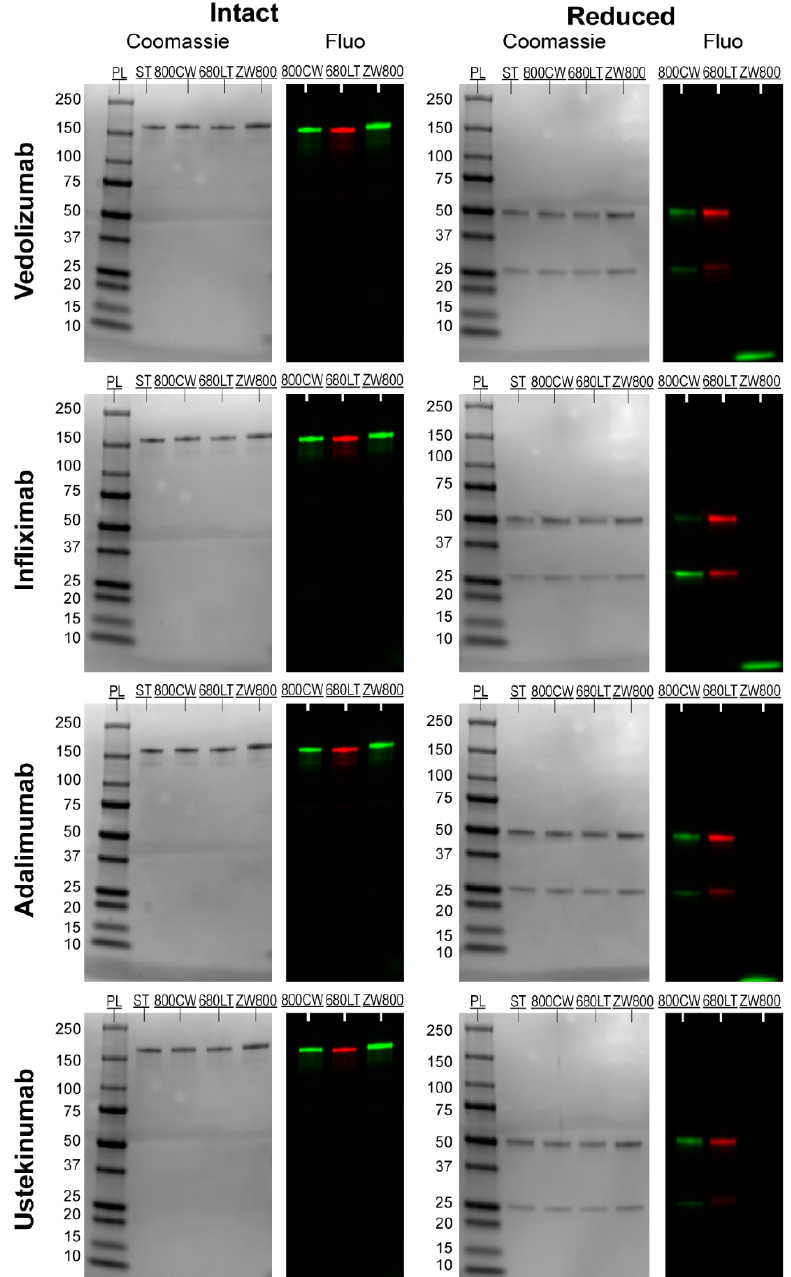
Figure 2. Coomassie-stained white light and Odyssey fluorescence images of sodium dodecyl sulfate polyacrylamide gel electrophoresis (SDS-PAGE) gels. Each image row represents a single antibody. Conjugated samples of all 3 dyes both intact and reduced were run on the same gel both intact and after reduction by β -mercaptoethanol. PL represents the protein ladder, molecular weights for the ladder are depicted left of the coomassie stained bands. Intact antibodies showed clearly defined single bands around 150 kDa, in line with the unmodified reference antibody (ST) lane. Reduced gels showed 2 clearly defined bands, at 50 kDa for heavy chain and 25 kDa for light chain. Fluorescence shows comparable results for all intact antibodies, which show up as clear single bands in their respective fluorescent wavelength (Green: 800 nm, red: 700 nm). After reduction, fluorescent bands can be seen at the 50 kDa and 25 kDa locations for all antibodies, except when conjugated to ZW800. A poorly defined band can be observed at the very bottom of the gel for lanes of reduced ZW800 tracers, while negligible signal is detectable at the reduced band locations. Abbreviations: Fluo: Odyssey CLX fluorescence scan; PL: protein ladder; ST: unconjugated protein reference; 800CW: lane with antibody conjugated to IRDye 800CW; 680LT: lane with antibody conjugated to IRDye 680LT; ZW800: lane with antibody conjugated to